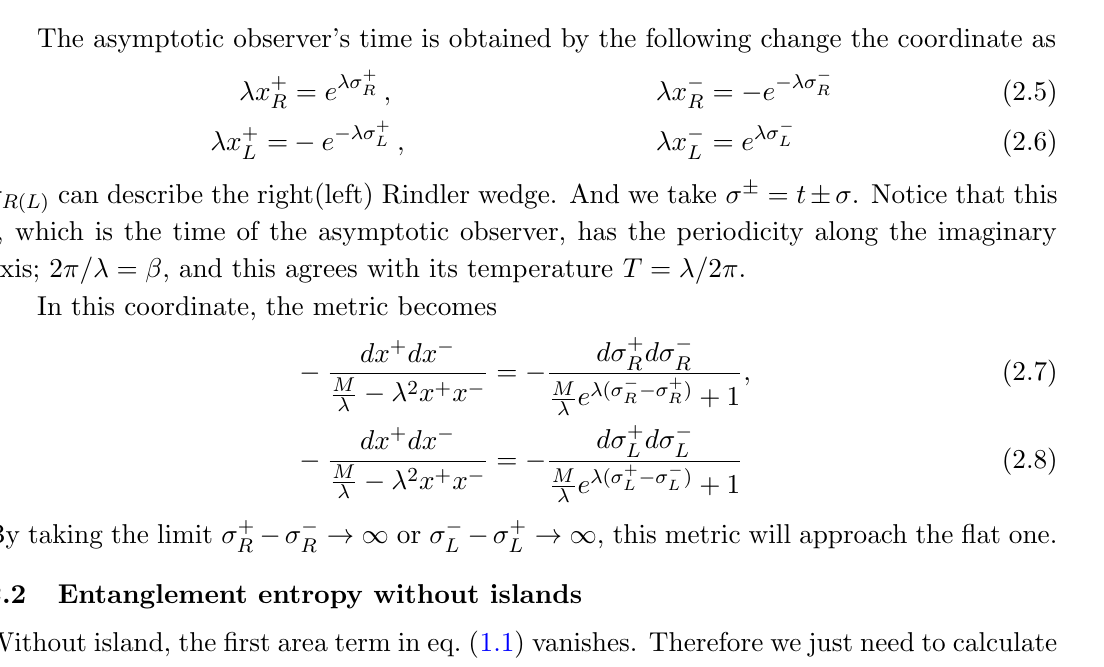
Figure 1 . We consider the entropy of the interval [ (cid:0)1 ; (cid:0) b ] L [ [ b; 1 ] R . This entropy, which is the entanglement entropy between pair created particles near the horizon, increases linearly and eternally in time at the late time. If unitarity is held, the (cid:12)ne-grained entropy cannot increase eternally and it must to reach to a (cid:12)xed value at the late time, which is contradicted with the linear